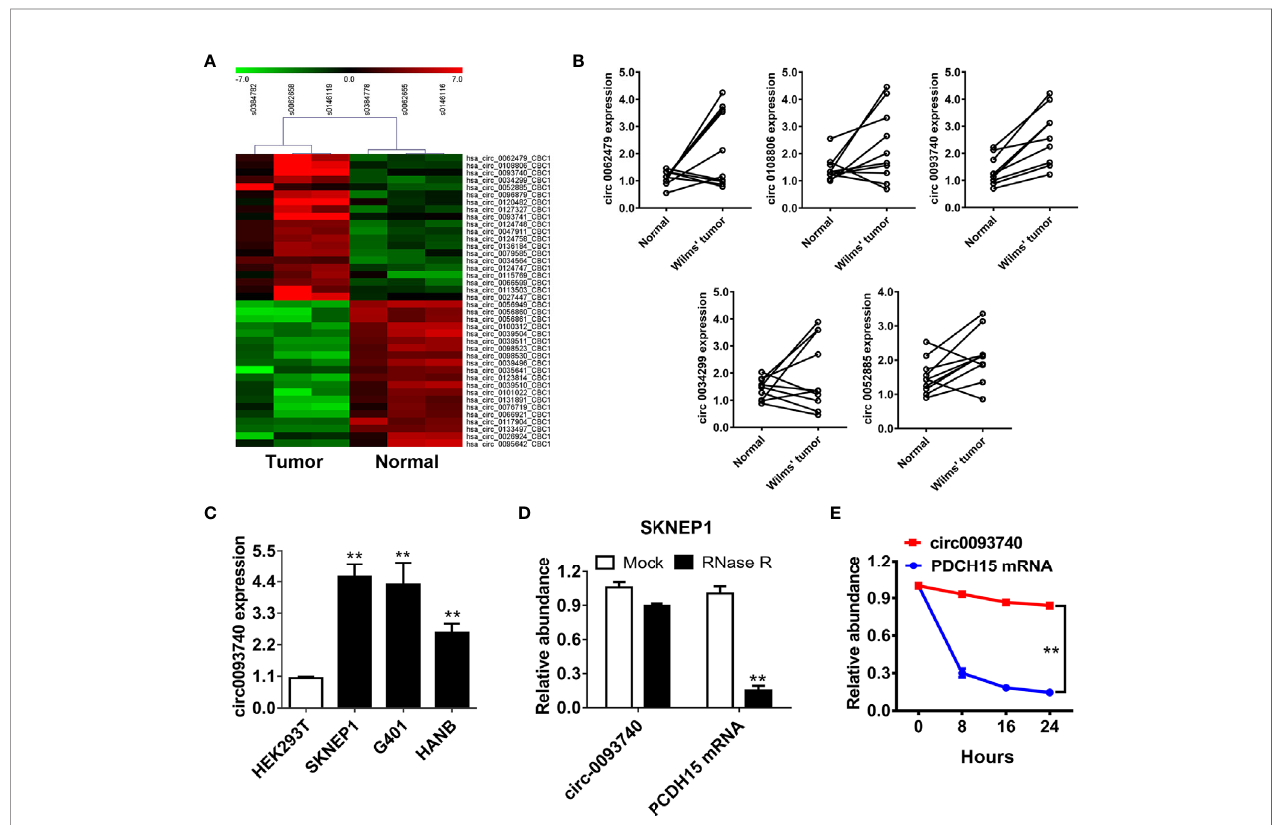
FIGURE 1 | circ0093740 is upregulated in Wilms tumor compared to normal kidney tissue. (A) The heat map depicted the differentially expressed circRNAs of three paired Wilms tumor and normal kidney tissue. (B) The relative expression level of top fi ve upregulated circRNA between Wilms tumor tissues and normal kidney tissues. (C) The relative expression level of circ0093740 in normal HEK293T cell line and Wilms tumor cell lines. (D) The circular structure of circ0093740 was tested RNase R assay in SKNEP1 Wilms tumor cell line. (E) Circular transcripts of circ0093740 were more stable than its linear PDCH15 mRNA transcripts determined by actinomycin D treated assay in SKNEP1 Wilms tumor cell line. **p <